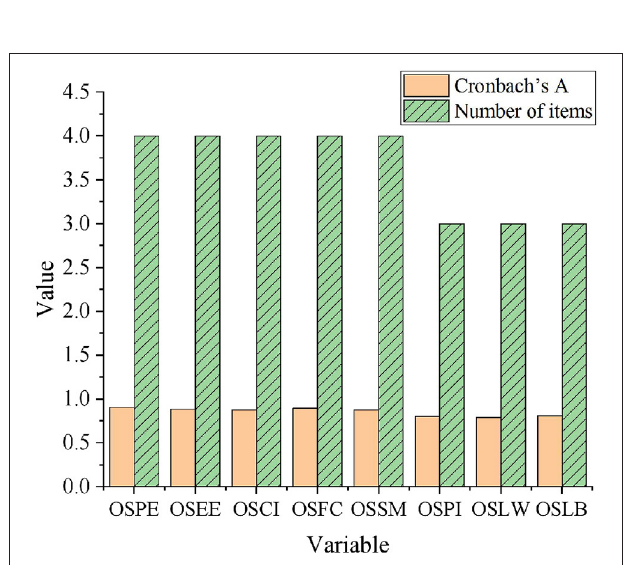
FIGURE 4 | Convergent validity of the scale. TABLE 3 | DV of the